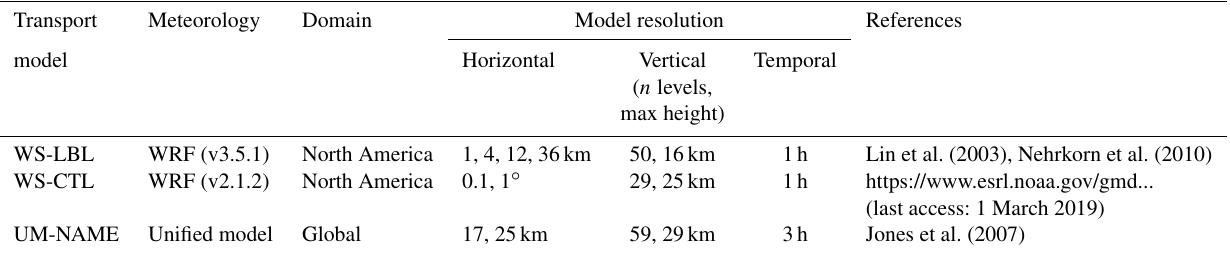
Table 2. Comparison of the three atmospheric transport models used in this study. Transport Meteorology Domain Model